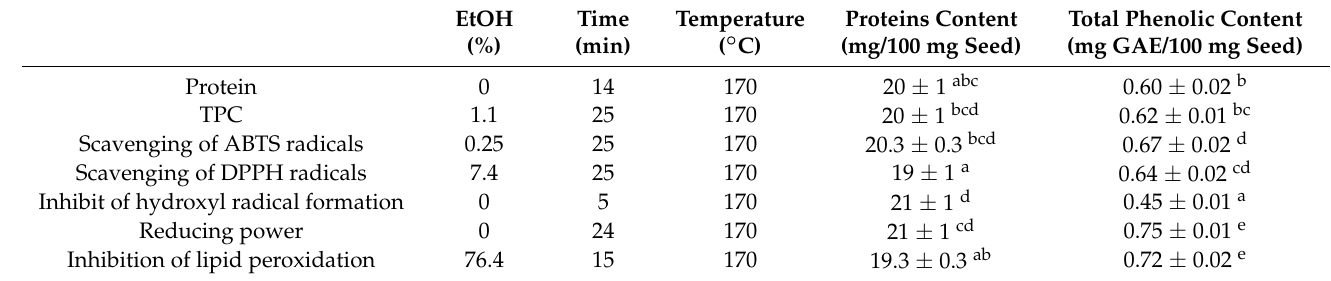
Table 2. Conditions predicted by Box–Behnken experimental design for obtaining the highest protein yield, TPC, scavenging of ABTS and DPPH radicals, inhibition of hydroxyl radical formation, reducing power, and inhibition of lipid peroxidation by PLE and protein content and TPC determined in extracts. EtOH Time Temperature Proteins Content (%) (min) ( ◦ C) (mg/100 mg